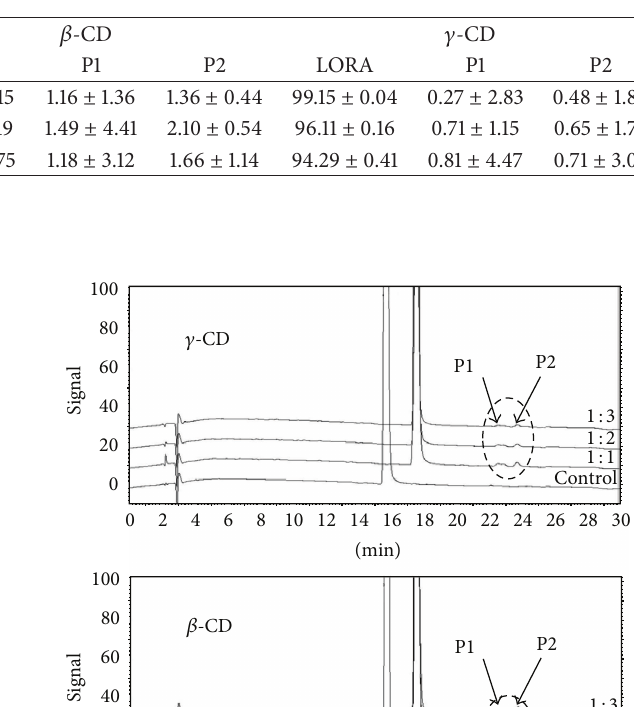
Table 2: Percentage of LORA recovered from binary complexes with 𝛼 -CD, 𝛽 -CD, and 𝛾 -CD, obtained by coevaporation, after 12 hours of irradiation in solution. The values correspond to the average of five determinations ± relative standard deviation ( ± DPR).